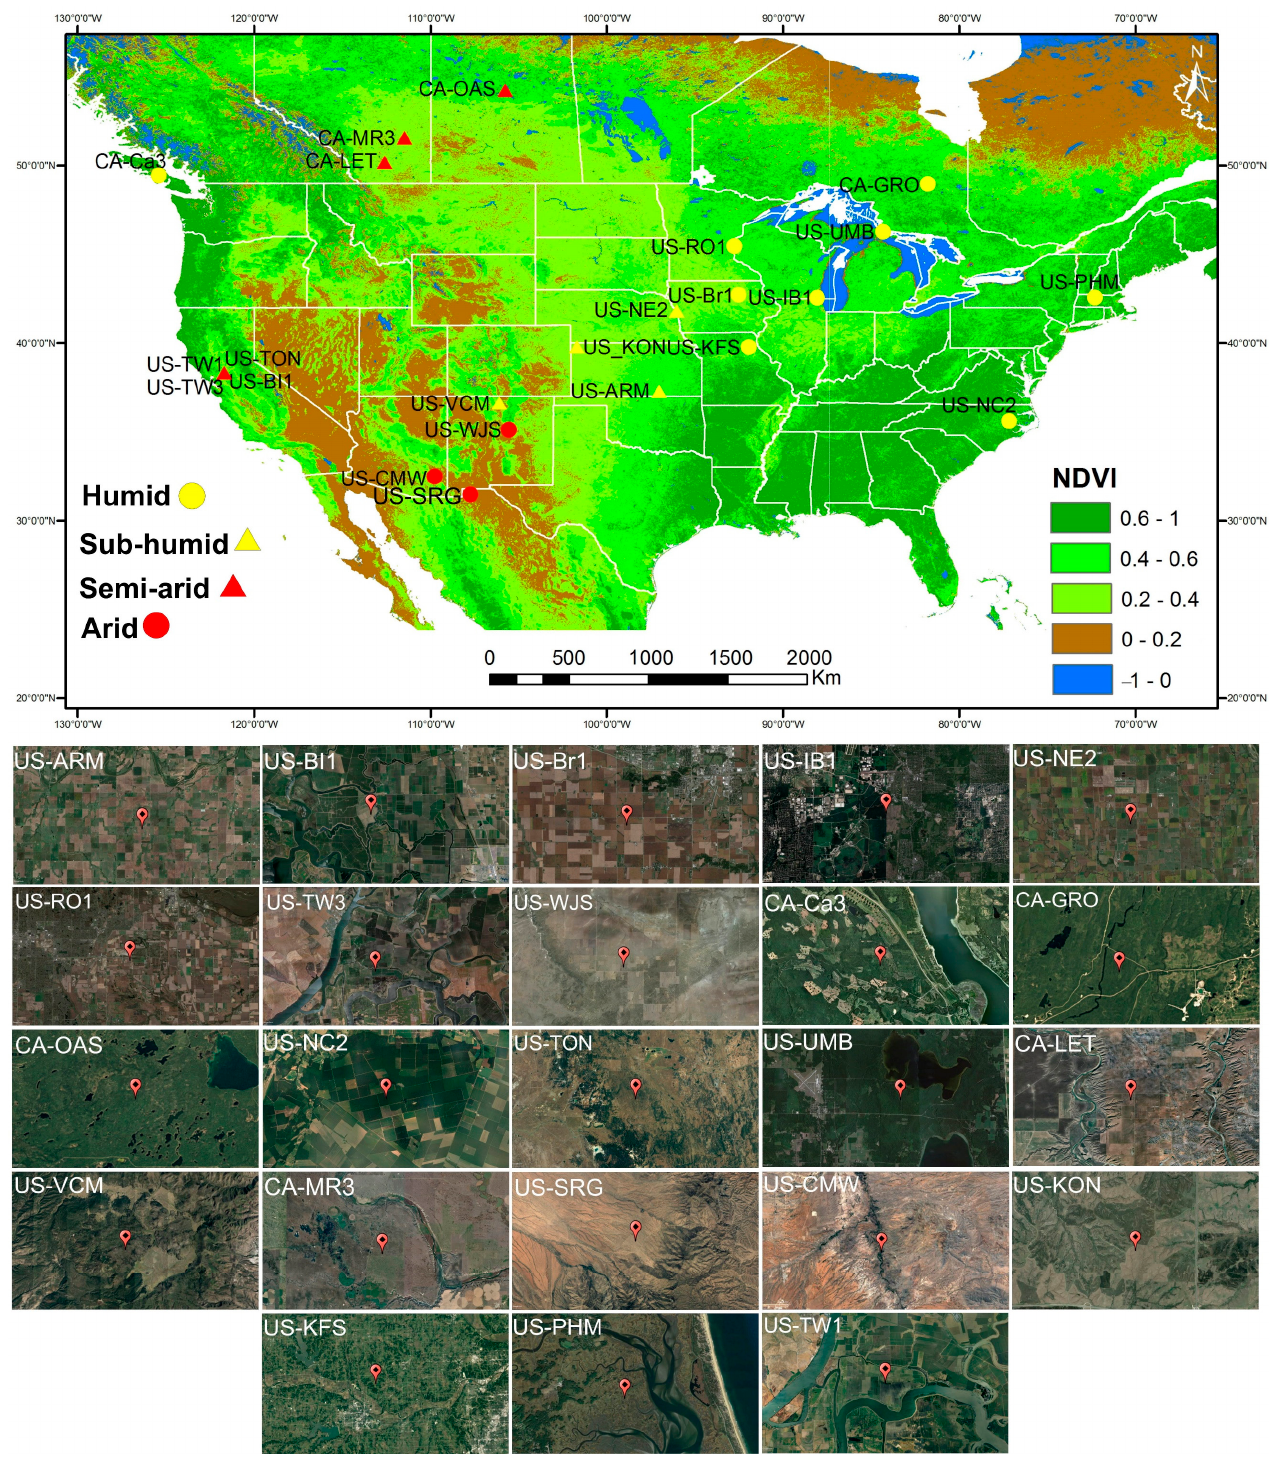
Figure 1. Location and climate types of flux tower sites used in this study.